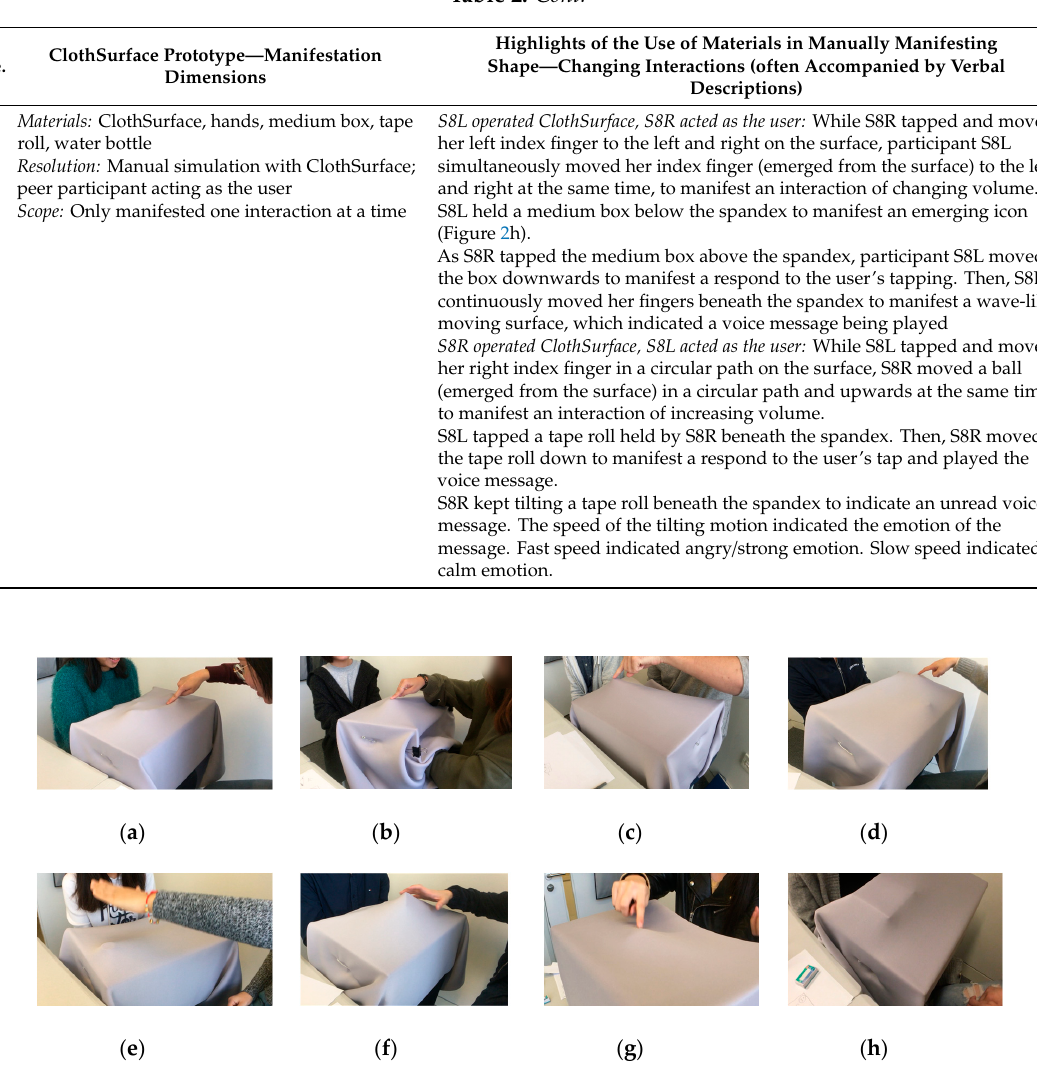
Figure 2. Highlights of manual manifestation with ClothSurface. For detail description of the pictures, refer to Tables 1 and 2.